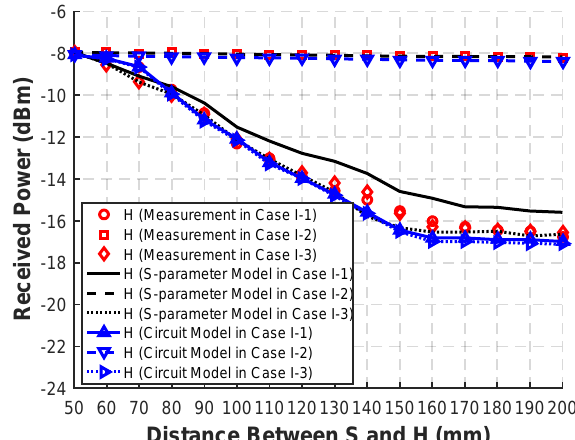
Figure 9. Measurement, simulated S-parameter model, and circuit model received power with different distances between S and H in the SSSH case in Case I-1 ∼ Case I-3, with only backward distance changing in Case I-1, only forward distance changing in Case I-2, and forward and backward distances remaining the same in Case